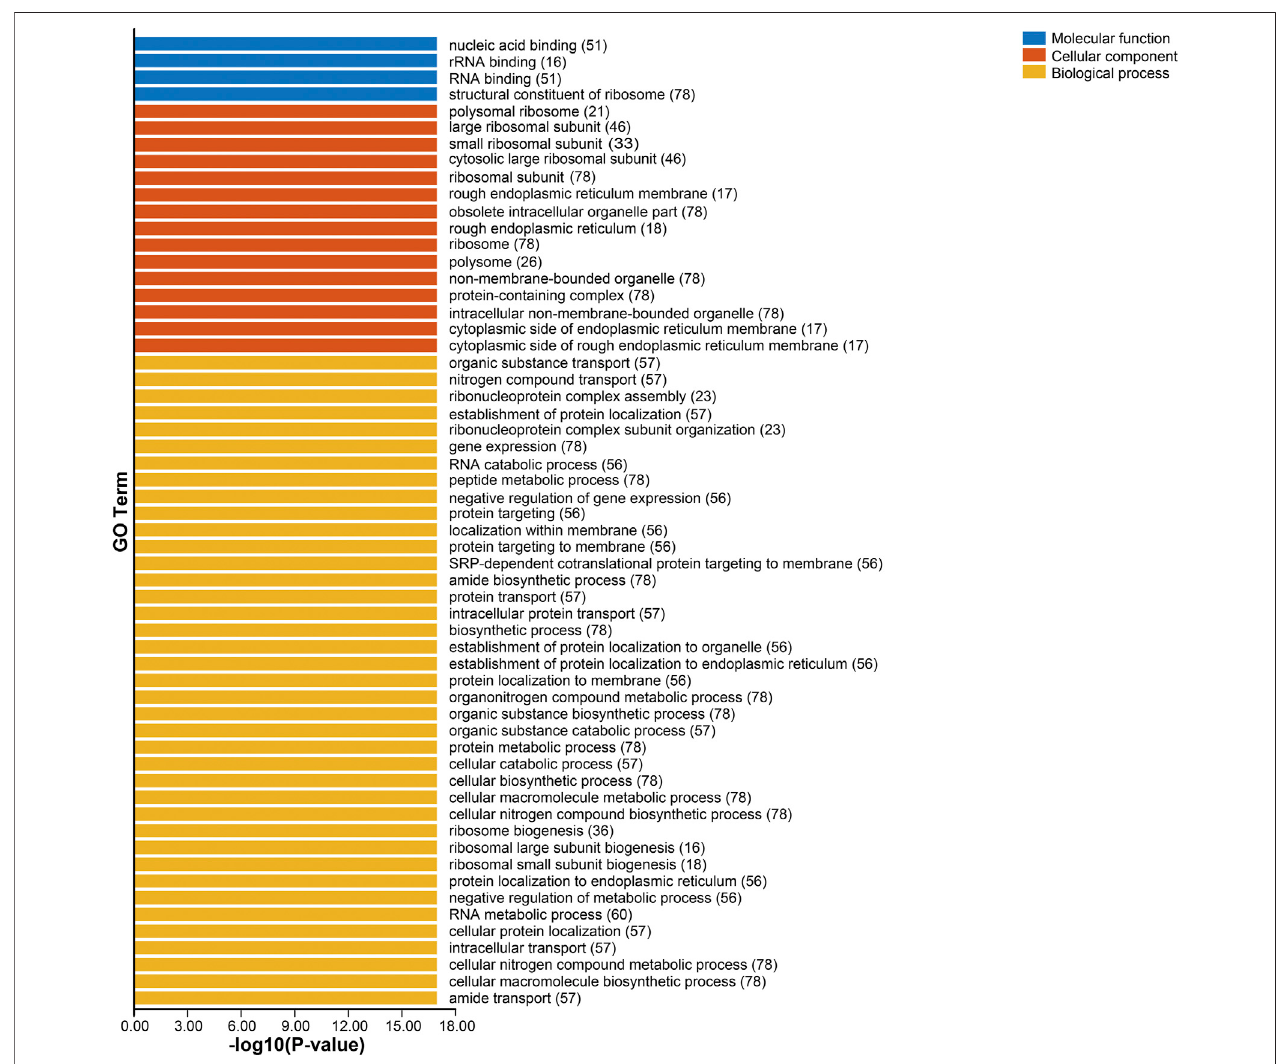
FIGURE 3 | The GO enrichment terms of Sl